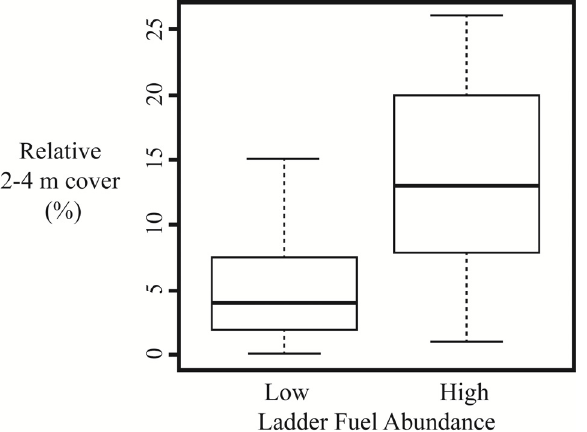
Figure 5. Box and whisker plot of the distribution of LiDAR-derived relative percentage of 2–4 m cover within plots having low and high ladder fuel abundance as derived from field plots using the methods of Menning and Stephens [18] ( n = 73); distributions were significantly different ( p < 0.001); median 2–4 m cover in high ladder fuel plots was 13.0%, while it was 4.0% in low ladder fuel plots; *outliers are not shown to simplify